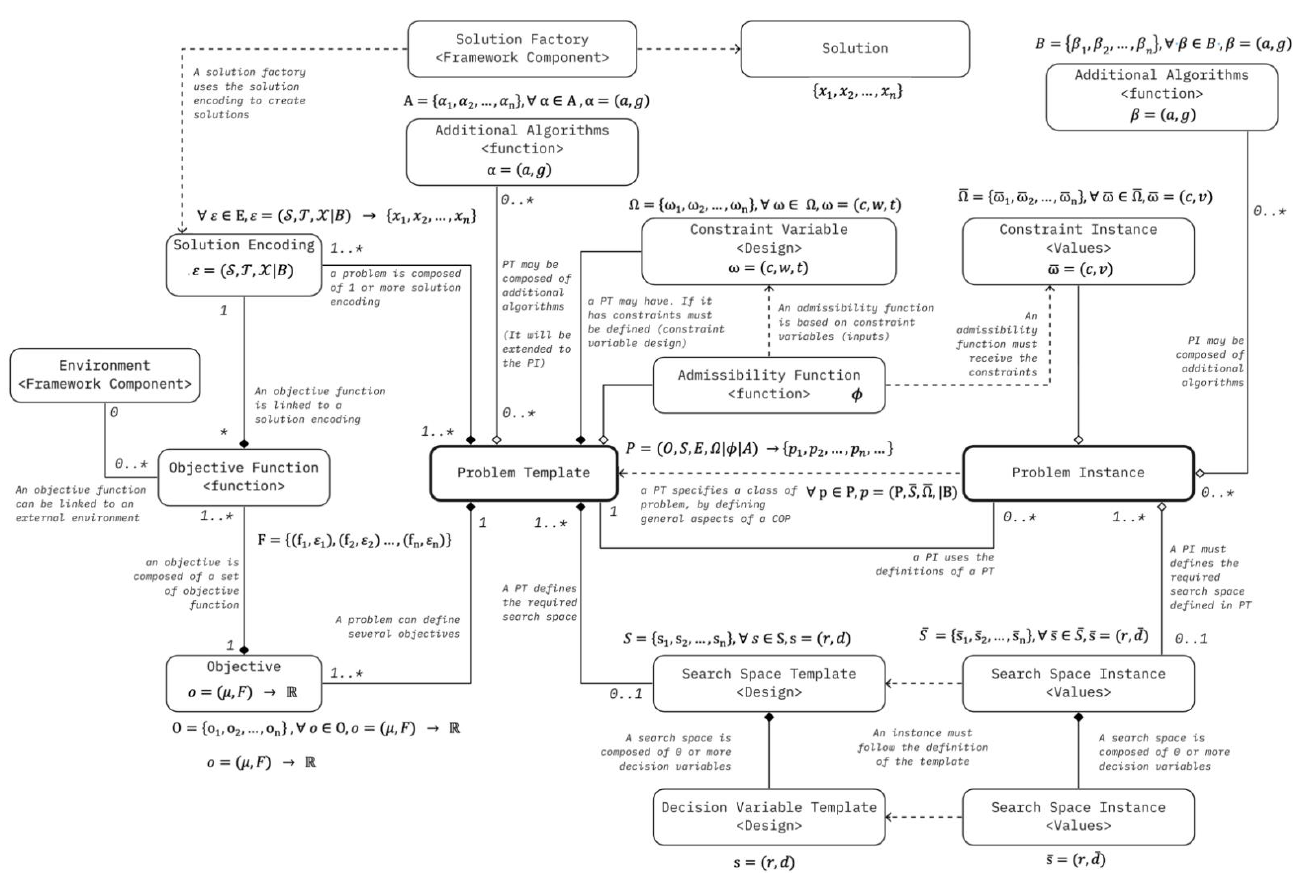
Figure 7. Problem building blocks and their relationships.